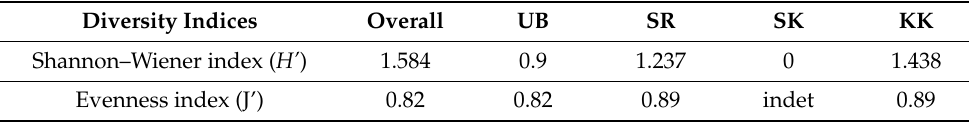
Table 5. Yeast community analysis. Diversity Indices